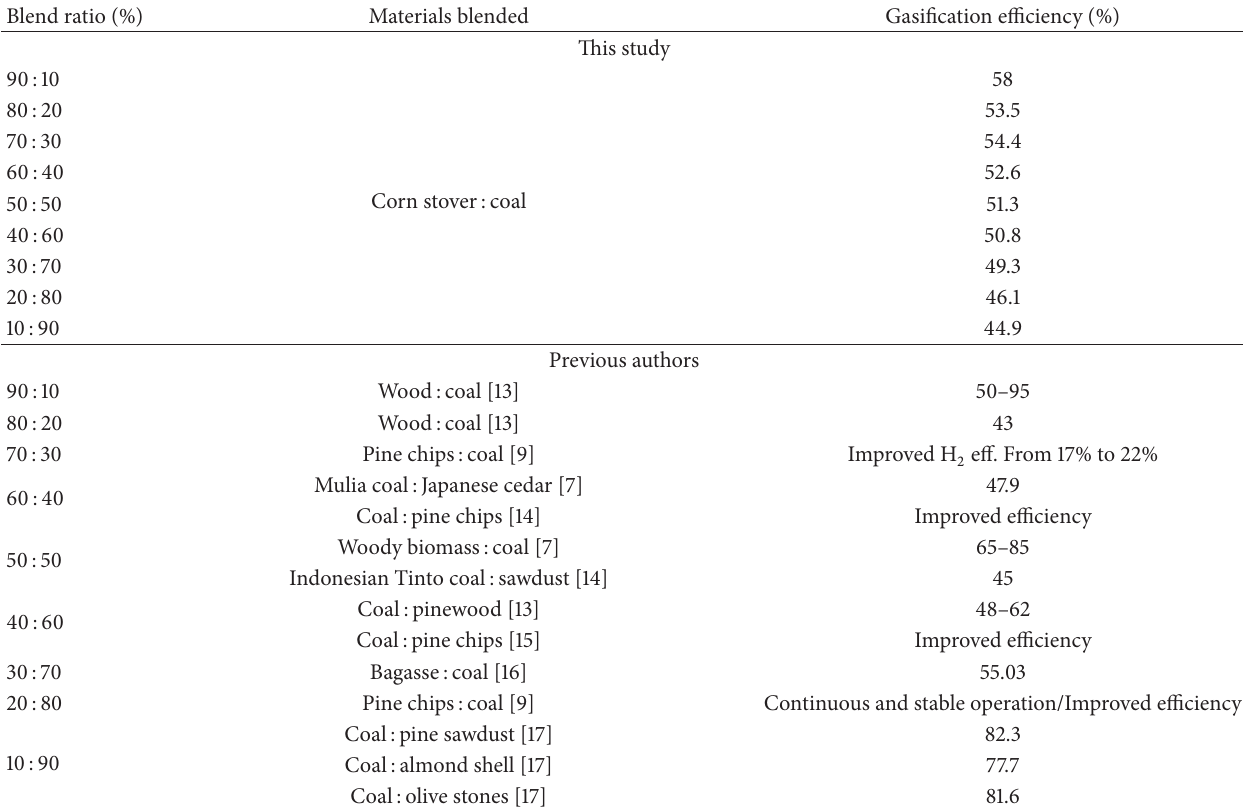
Table 3: A comparison of the simulated results from this study with experimental data from the